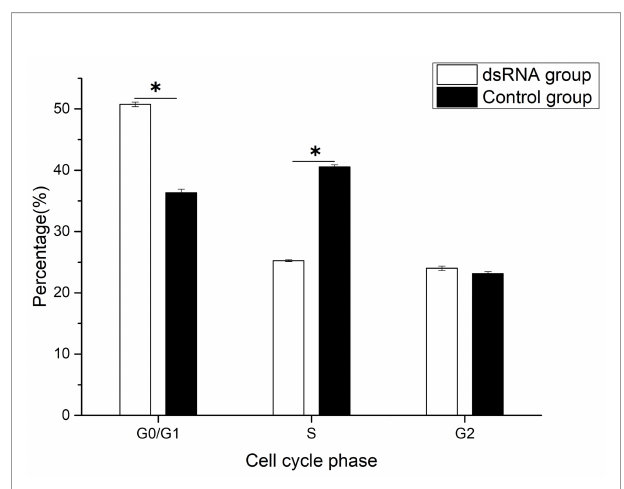
FIGURE 7 | Cell cycle phase distribution of gill cells in Hyriopsis cumingii after Hc-CDK6 RNAi, *Signi fi cant difference ( P < 0.05), Maximum value of vertical axis is